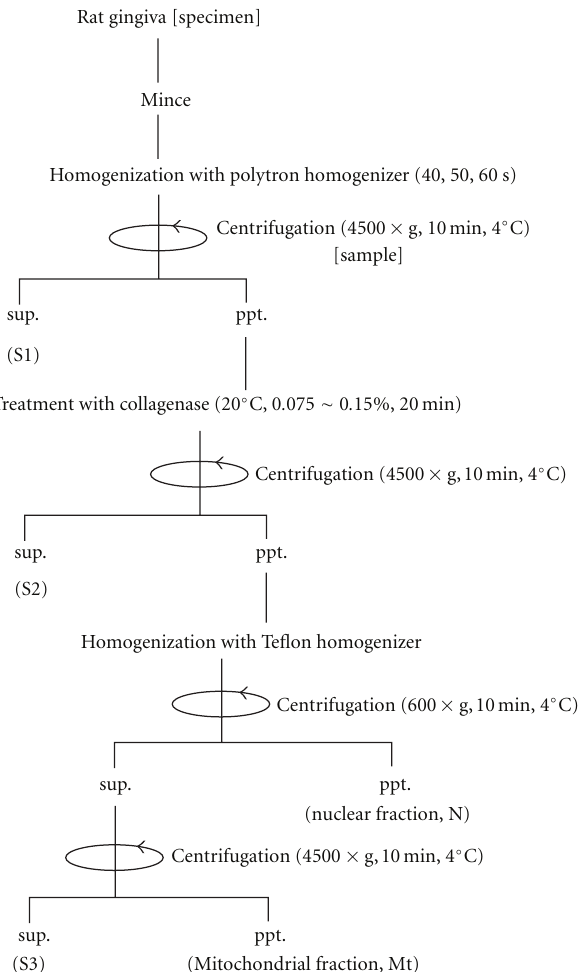
Figure 1: Diagrammatic representation of the mitochondrial (Mt) preparation procedure from gingival tissue in rats. Tissue specimens were washed and minced with 5.0 mM MOPS bu ff er (pH 7.4) and then intermittently homogenized at 4 ◦ C using a polytron homogenizer for 40, 50, and 60 sec. The homogenized gingival sample was centrifuged at 4,500 g for 10 min, the supernatant was labeled as S1, and the sediment was incubated in a Hanks solution (pH 7.4) containing 0.115%–0.130% (w/v) collagenase at 20 ◦ C for 20min. Following the enzymatic treatment, the homogenized gingival sample was centrifuged at 4,500 g for 10min. When the supernatant is labeled S2, the sediment was diluted with 50 mM MOPS bu ff er containing 100mM KCl, 0.2mM EDTA, and 0.2% (w/v) BSA and homogenized using a Teflon homogenizer for one min. The homogenate was centrifuged at 600 g for 10 min and the sediment was collected as the nuclear (N) fraction. The supernatant was then centrifuged at 4,500 g for 10 min, the supernatant was labeled as S3, and the sediment was finally collected as the mitochondrial (Mt)